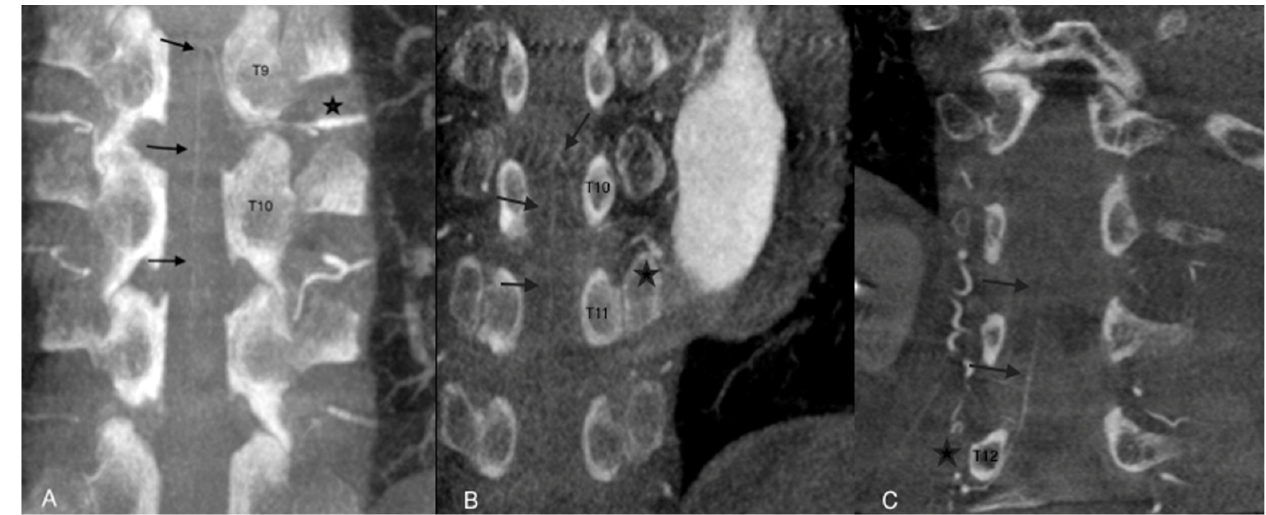
Figure 2. Examples of angio-CBCT reconstructions showing the Adamkiewicz artery (AA) (black arrows) in three different patients. The AA is seen running obliquely along the anterior surface of the spinal cord with a classic hairpin turn and connection to the anterior spinal artery (star). In cases ( A , B ), the feeding artery of the AA was clearly depicted. In case ( C ), complementary selective arteriography was performed.